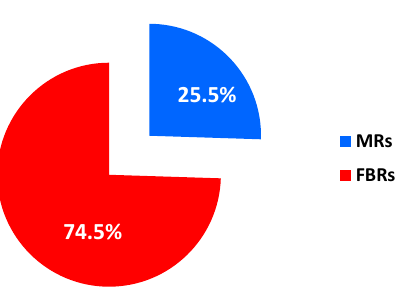
Figure 2. Percentage distribution about the modelling of MSR reaction involving FBRs and MRs (Scopus database: www.scopus.com).